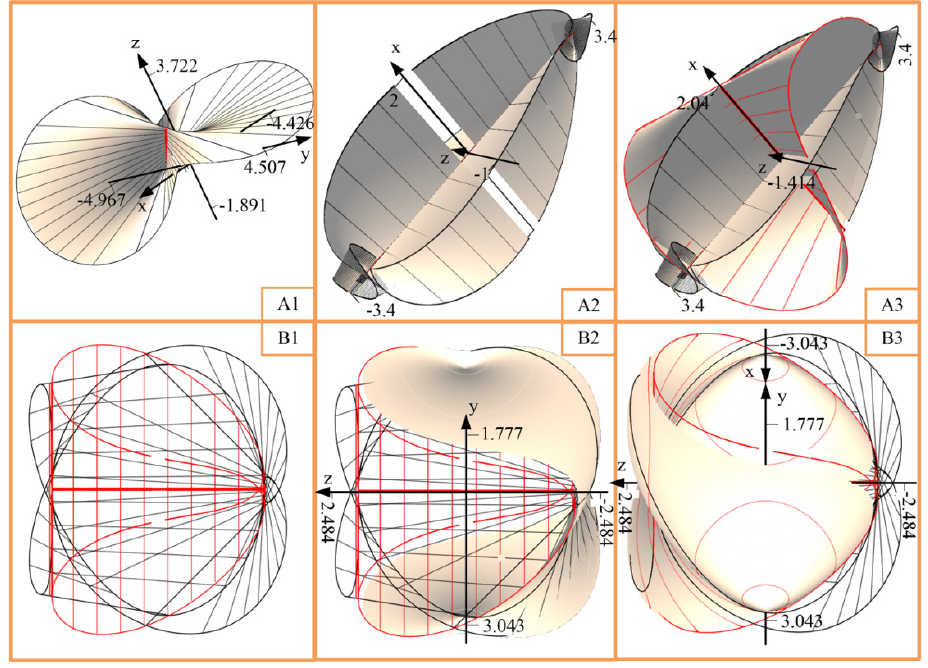
Figure 10. TCs, FSCs, and SSC, and their boundary surfaces.